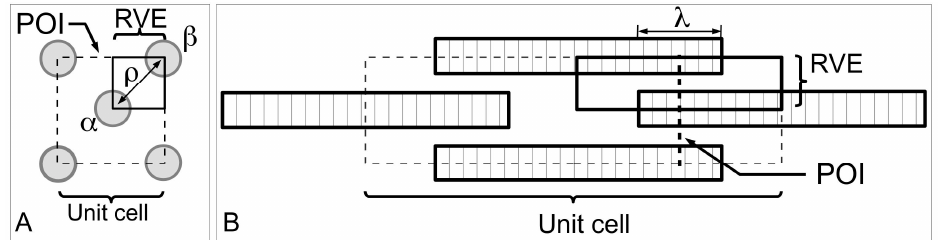
Figure 13. Model of ECM containing short (uniform cylindrical) collagen fibrils arranged in the square-diagonally packed configuration. ( A ) A cross-sectional (plane of interest, POI) view; ( B ) The longitudinal view of the unit cell. In part ( A ), α refers to the primary fibril of interest; surrounding the α fibril are the β (secondary) fibrils of interest. Here, RVE represents representative volume element; λ and ρ represent the fibril-fibril axial overlap distance and the centre-to-centre lateral separation distance, respectively.